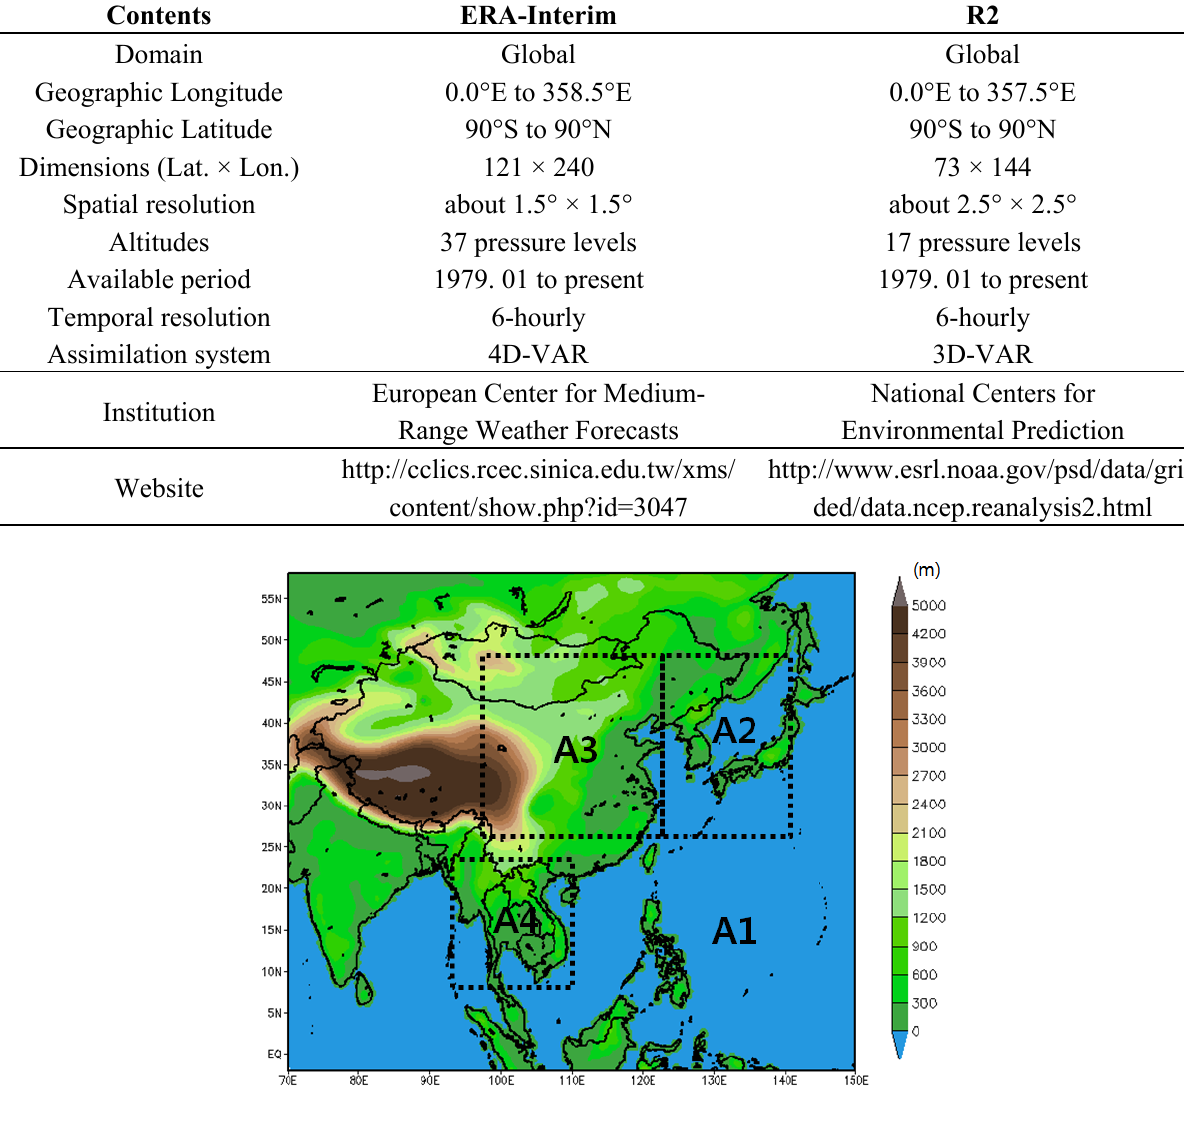
Figure 1. Model domain for CORDEX-EA showing elevation (m) and the sub-regions used in this